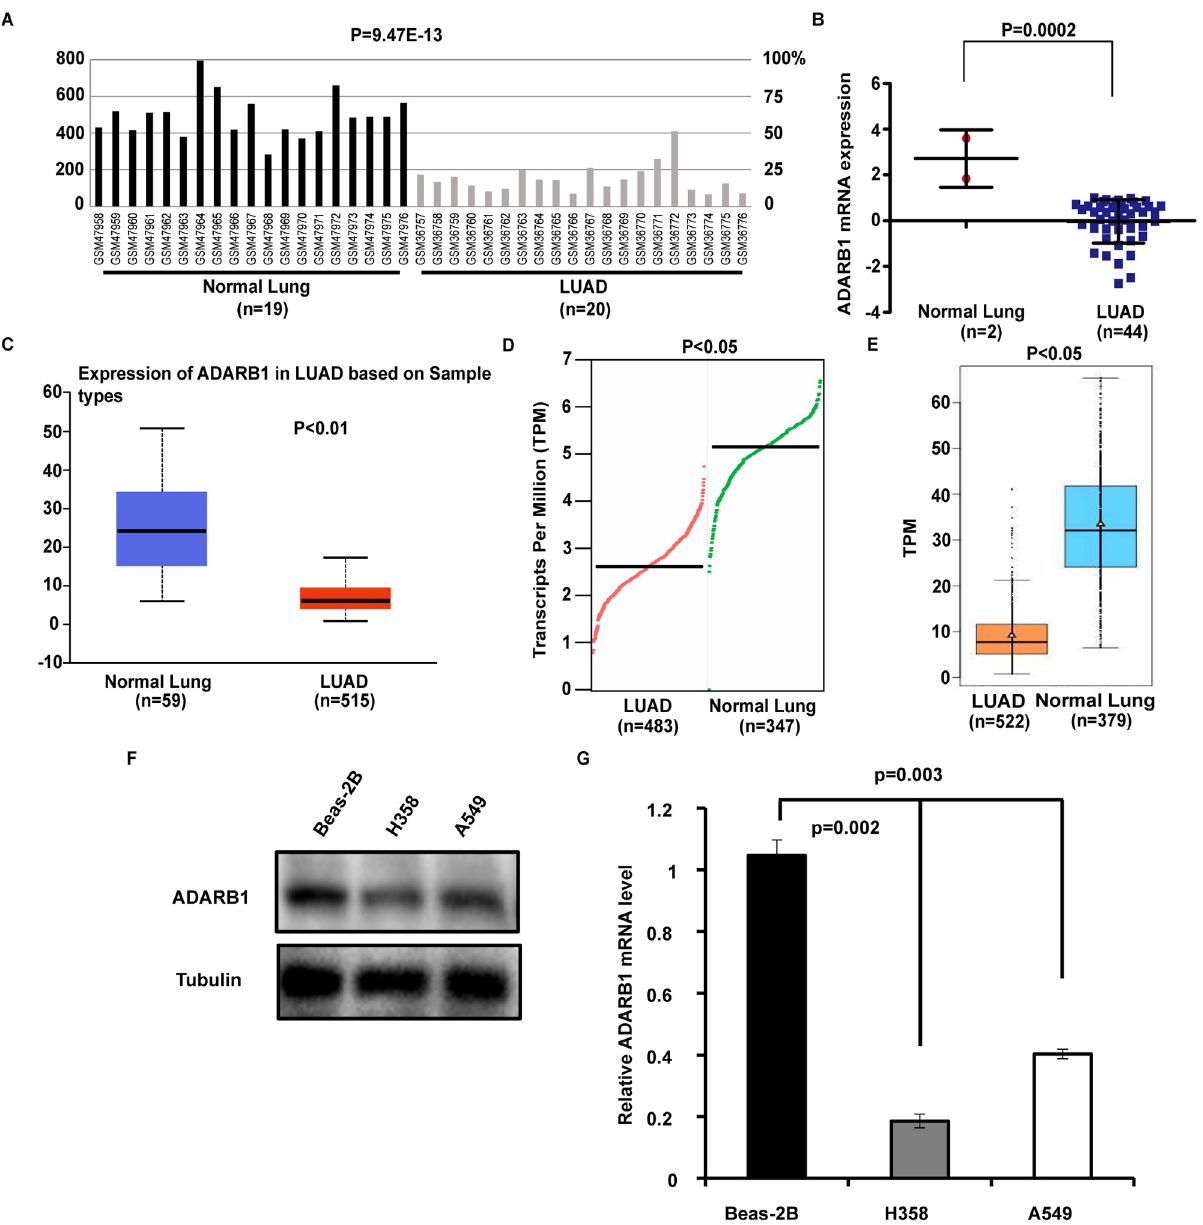
Fig 2. Analysis of ADARB1 expression levels in LUAD tissues and cell lines. (A) One dataset GSE2514, downloaded from the GEO database, described the mRNA expression of ADARB1 in LUAD in relation to normal lung tissues. (B) ADARB1 mRNA levels were significantly decreased in 44 LUAD cell lines, compared to 2 normal cell lines. (C-E) The mRNA expression of ADARB1 was evaluated from the database UALCAN, GEPIA and GE-mini, respectively. (F-G) Expression of ADARB1 was analyzed by qPCR and western blot.